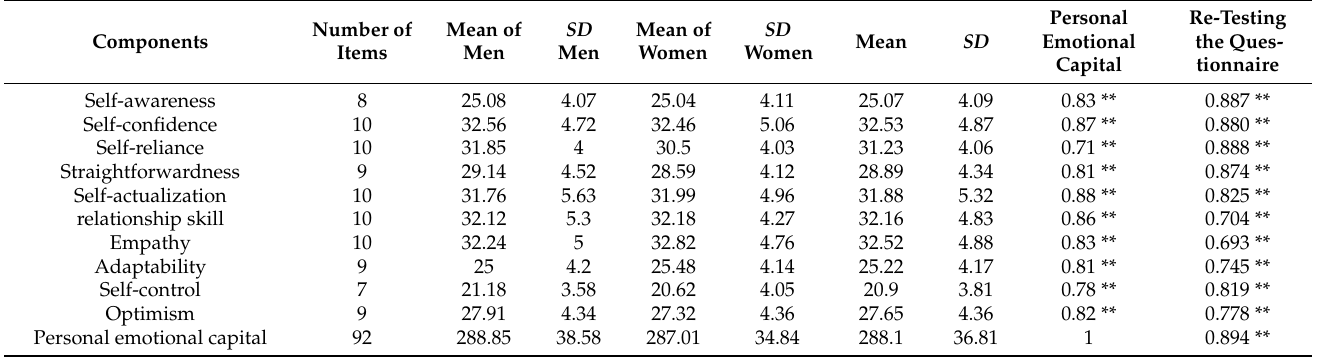
SD SD Number of Mean of Mean of Mean SD Items Men Men Women Women